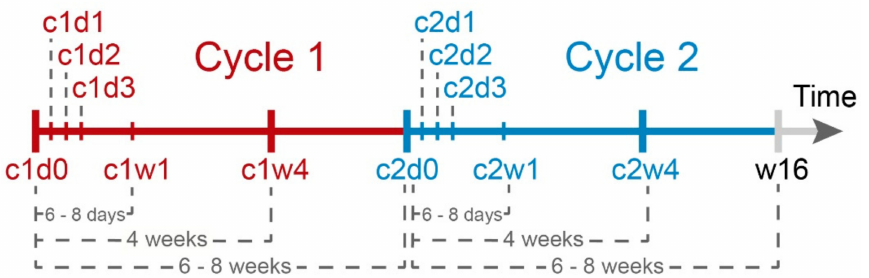
Figure 1. Treatment schedule of PSMA radioligand therapy and study design (designation of time and intervals of PSA measurements). c: therapy cycle, w: week of therapy cycle and d: day of therapy